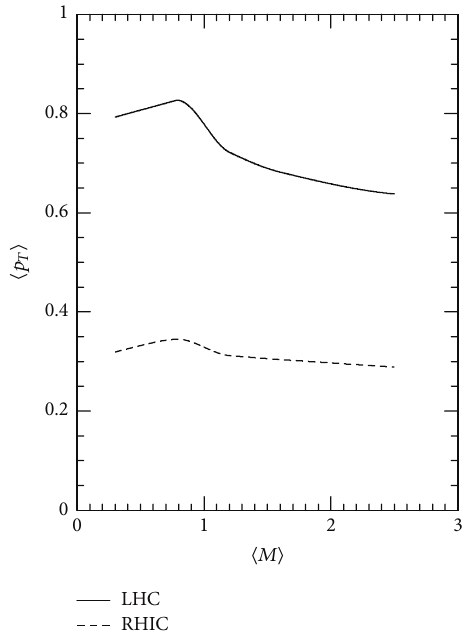
Figure 33: Variation of ⟨𝑝 𝑇 ⟩ as function of 𝑀 (see